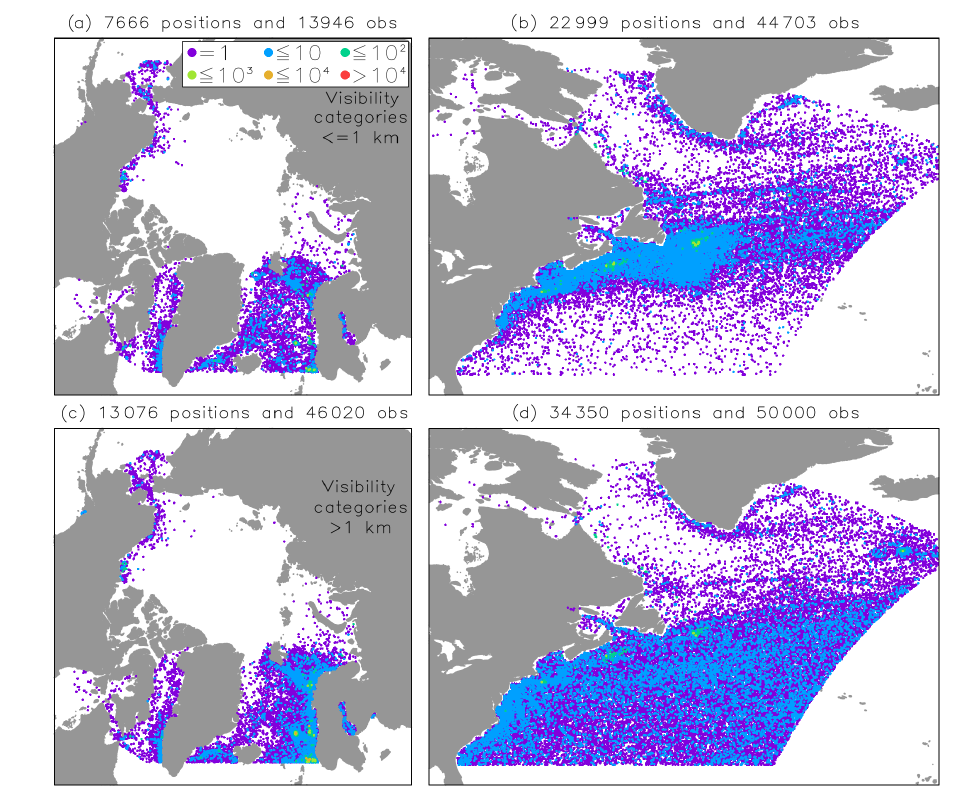
Figure 1. Ship and fixed platform marine observations of (a, b) fog and (c, d) non-fog visibility taken between January 1979 and Decem- ber 2004 to the north of (a, c) 60 ◦ N in the Arctic and (b, d) 30 ◦ N in the North Atlantic and within regional WRF model domains. Titles show the total number of ICOADS positions and observations, given at 0.1 ◦ resolution with order-of-magnitude color labels in (a)